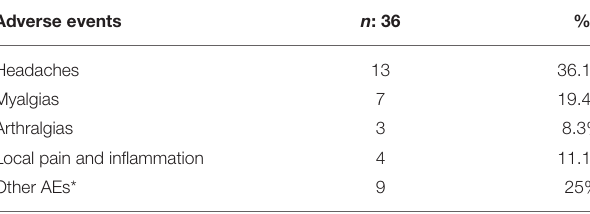
TABLE 4 | Adverse events reported during omalizumab treatment. Adverse events n :